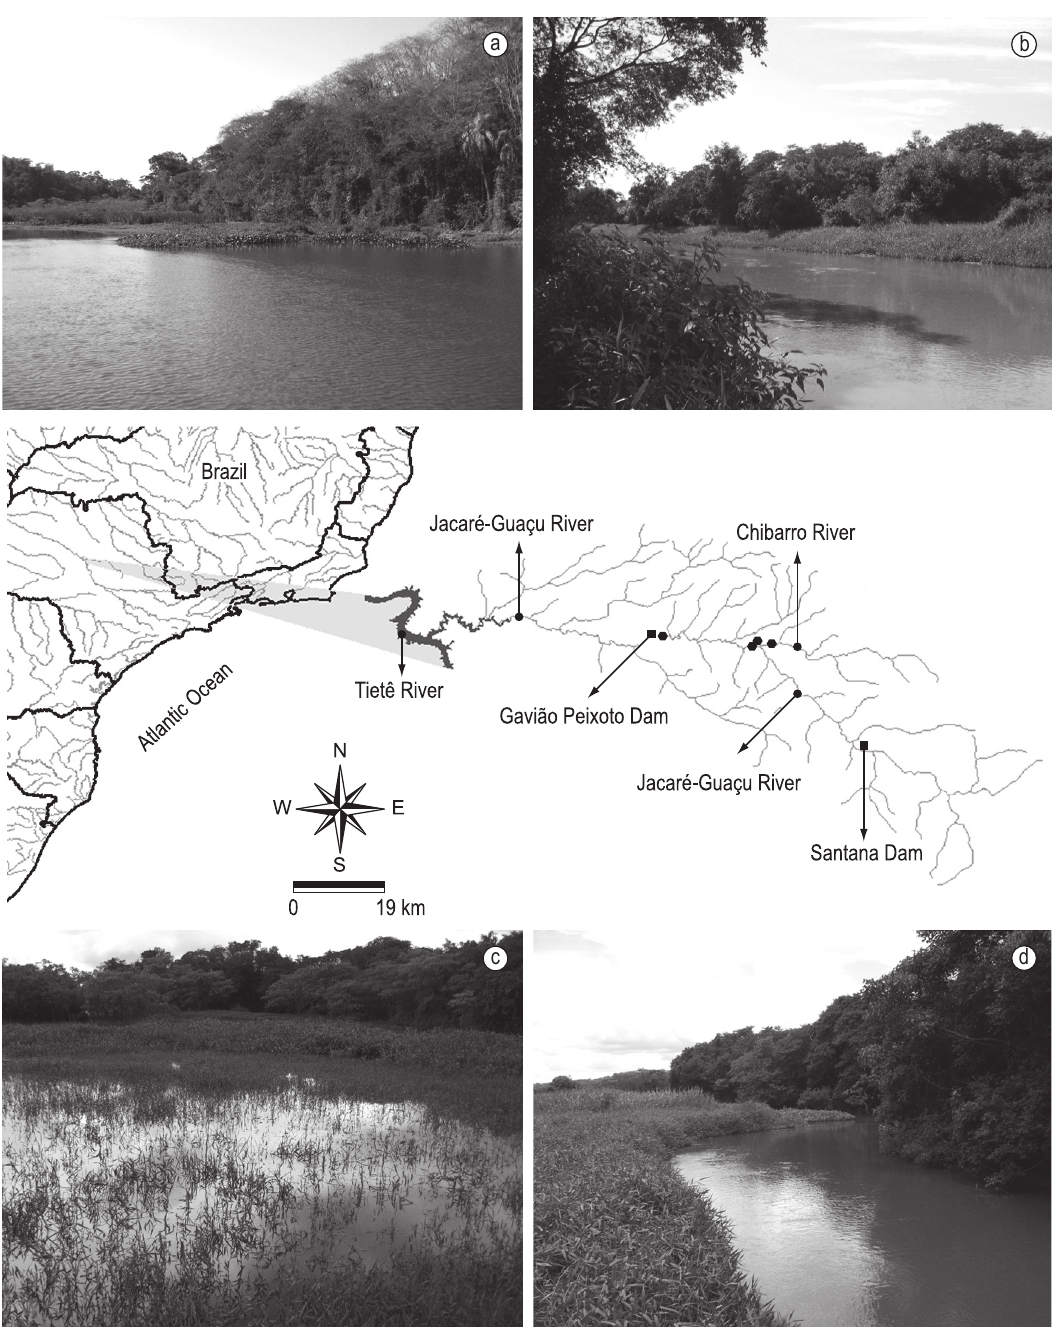
Figure 1. Location of the Jacaré-Guaçu basin in Brazil and of the four habitats in the Jacaré-Guaçu basin and their pictures: a) The reservoir of Gavião Peixoto Dam; b) Jacaré-Guaçu River; c) floodplain lake; d) Chibarro River.